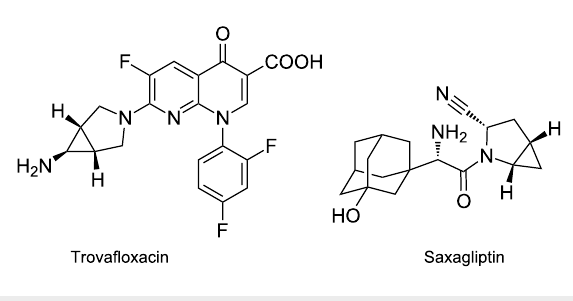
Figure 2: Pharmaceuticals bearing an azabicyclo[3.1.0]hexane unit.